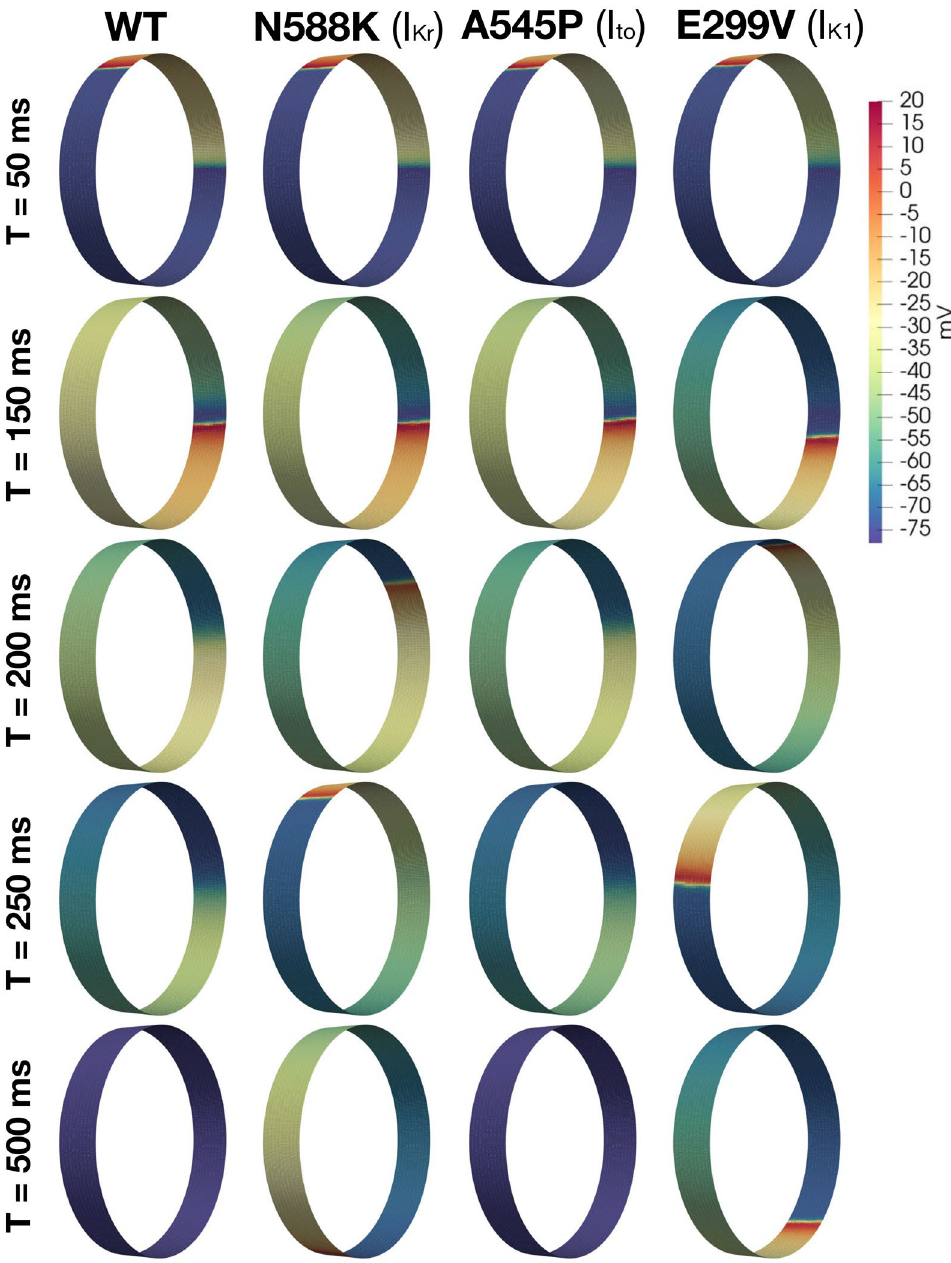
Figure 8. EMI-based multicellular simulations of electrical propagation and re-entry in the cylinder segment of the PV sleeve tissue. We use the simulation protocol described in the “Re-entry” section for investigating re-entry. Data are illustrated for WT, and the N588K, A545P, and E299V mutations (columns). Specifically, we show the intracellular potential of the cells in the PV sleeve at five different times after stimulation (rows). Note that to improve the visual resolution, the transversal axis of the myocytes has again been stretched by a factor of